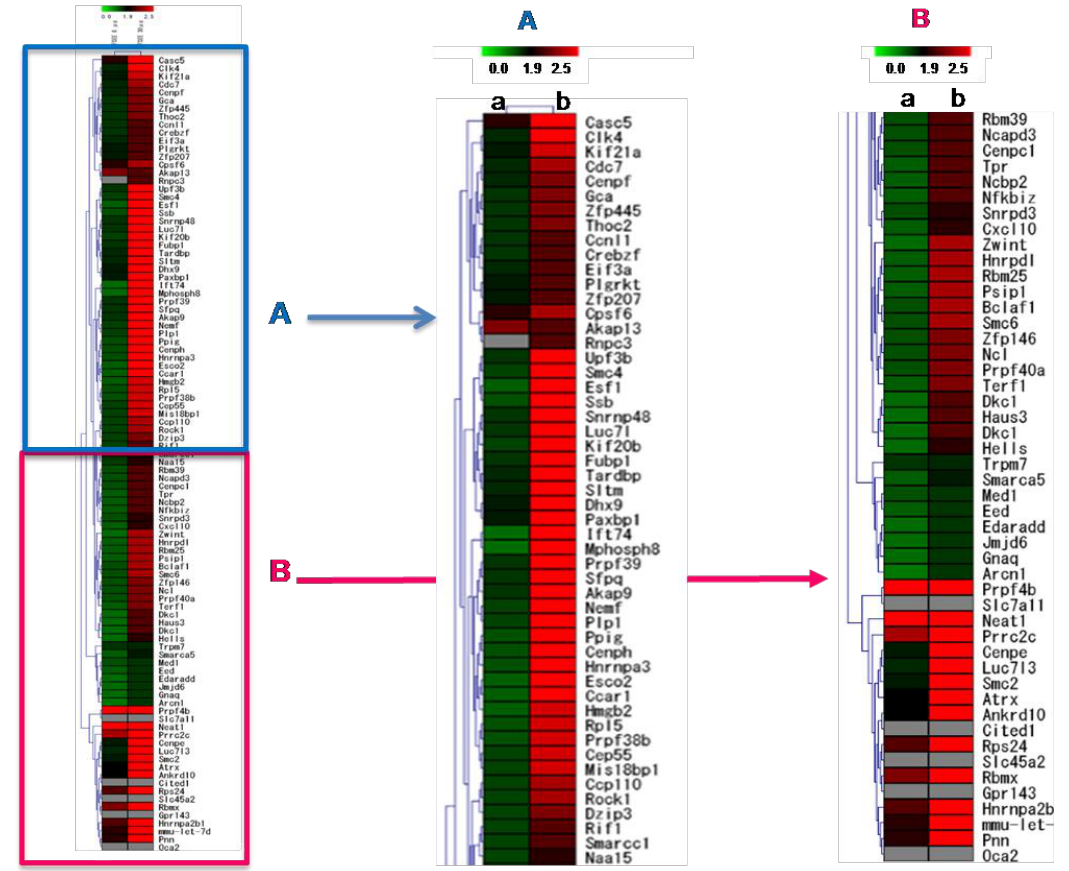
Figure 7. Heat map representing the e ff ect of argan fruit shell ethanol extract (AFSEE) on global gene expression in B16F10 cells and the hierarchical clustering of genes that were di ff erentially expressed in B16F10 cells treated without (control) or with (a) AFSEE (6 µ g / mL) or (b) AFSEE (30 µ g / mL) for 4 h. The 25 downregulated genes subjected to hierarchical clustering had a fold-change value of ≤ –1.5 (vs.control), while for the upregulated genes, genes with ≥ 1.5-fold change values were chosen. The map is split into two ( A , B ) for clarity. The Euclidian distance method was used for the comparison, and the resulting red and green colors represent gene up- and down-regulation, respectively. Table 1. List of up- and down-regulated genes in B16F10 melanoma cells treated with AFSEE (6 µ g / mL and 30 µ g / mL), as determined by DNA microarray.